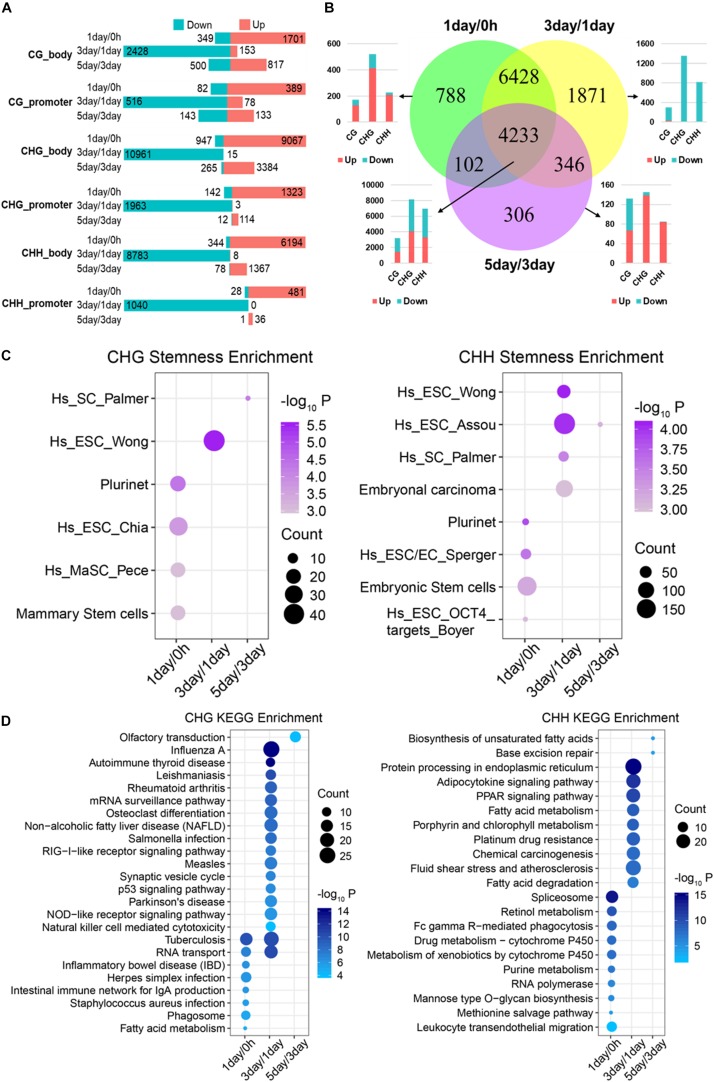
Functional analysis acid of stage-specific differentially methylated genes. (A) Distribution of DMGs in different groups. Red and cyan in parts A and B indicate that the methylation level is increased or decreased in comparison. (B) Venn-like diagram shows overlapping DMGs among three stages. The bar plot shows the number of each stage-specific DMGs and the three-stage common DMGs (Bottom left). (C) Stemness enrichment analysis (P < 0.05) of stage-specific DMGs of CHG (Left) and CHH (Right) methylation. (D) Significantly enriched terms (FDR < 0.01) in KEGG pathway for stage-specific DMGs of CHG (Left) and CHH (Right) methylation. CC, cellular component; BP, biological process; MF, molecular function.